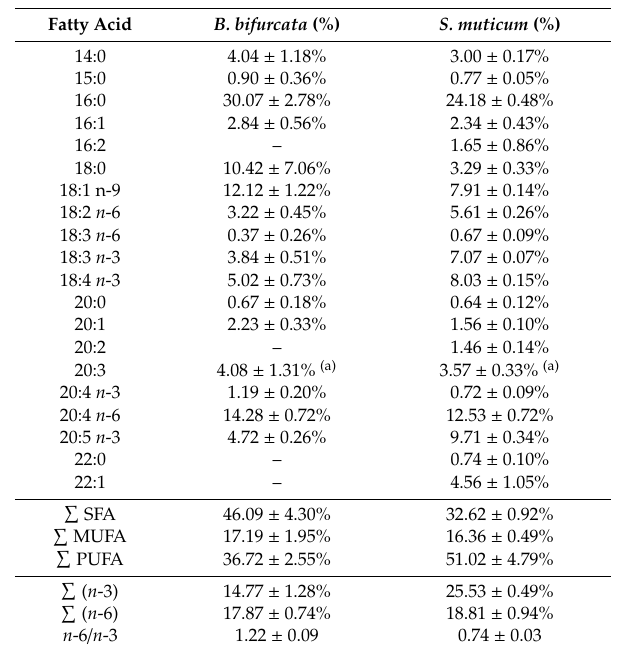
(Table 1). PUFA content of B. bifurcata was lower than that of S. muticum. Table 1. Fatty acid profile of Bifurcaria bifurcata and Sargassum muticum determined by gas chromatography-mass spectrometry (GC–MS) analysis fatty acid methyl esters (FAME) and expressed as relative abundance mean (%) + SD, n =